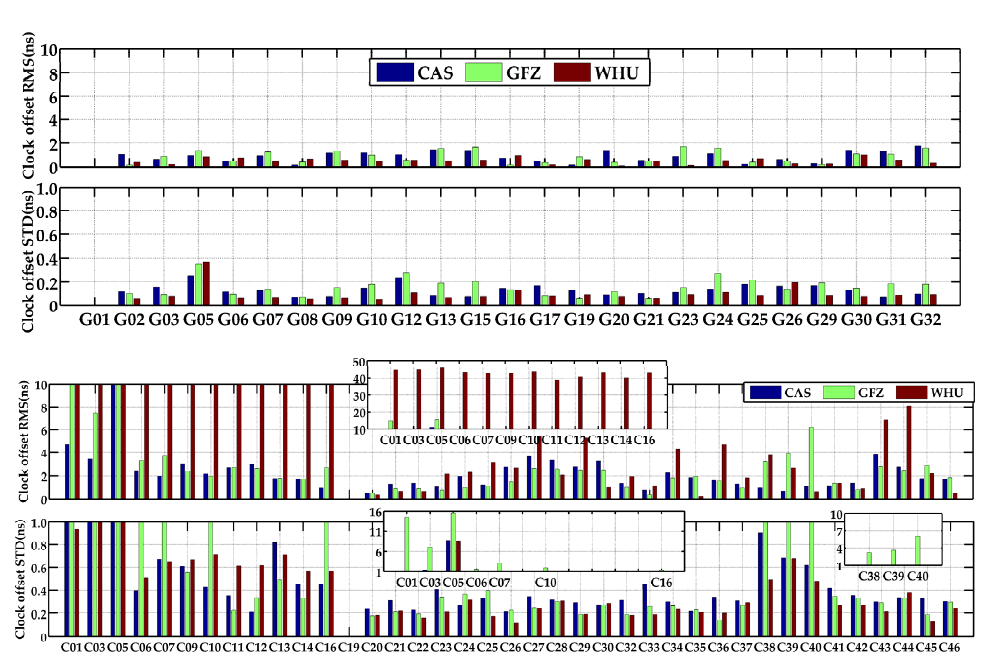
Figure 7. Clock offset RMS and STD of real-time products of GPS satellites ( top ) and BDS satellites ( bottom ) from each analysis center.